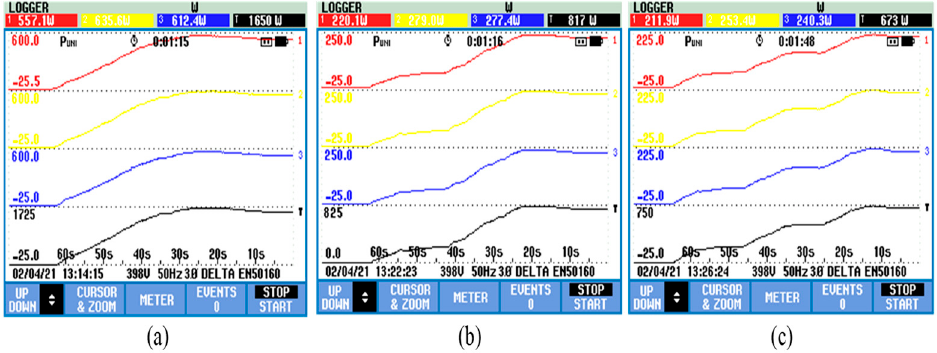
Figure 15. Power curve of ( a ) single pump curve, ( b ) two pump curve ( c ), three pump curve.